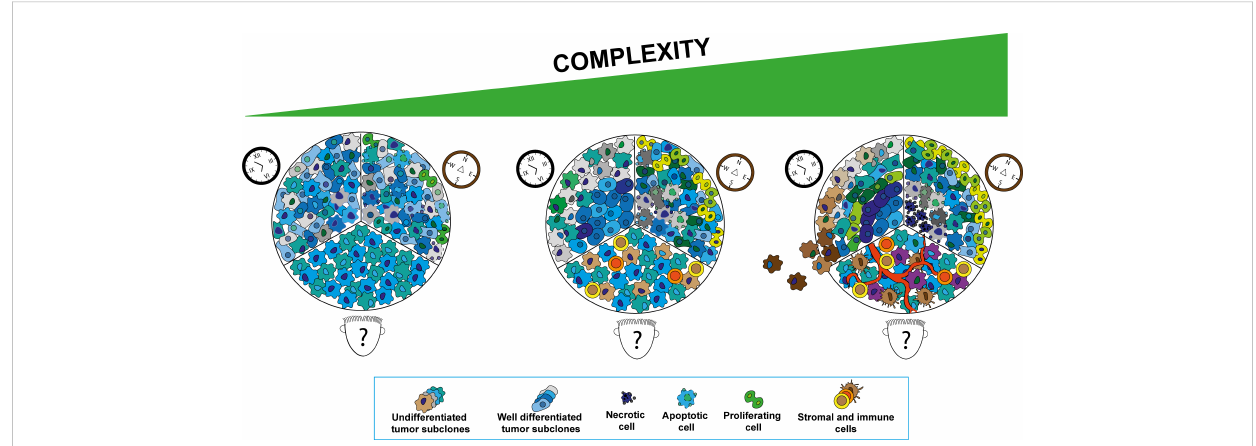
FIGURE 1 Schematic representation of the tumor development aspects to be consider in cancer modeling subdivided in three main aspects. “ Who? ” cellular populations composing the tumor microenvironment (TME) (human face cartoon), “ Where? ” spatial distribution of the different cellular components in the TME (compass cartoon) and “ When? ” tumor development at different stages (clock cartoon). Increase in complexity in tumor modeling can be reached progressively adding different tumor sub-clones, stromal and immune cells in the system at the ratio reported in the tumor subtypes of interest. The original spatial distribution of cellular components in tumor tissues can be mimicked by reconstructing regions characterized by different biochemical gradients (i.e., oxygen, metabolites) and physical properties. The different stages of neoplastic transformation can be reproduced by systems able to recapitulate the tumor initiation and progression processes closely recapitulating the oncogenic